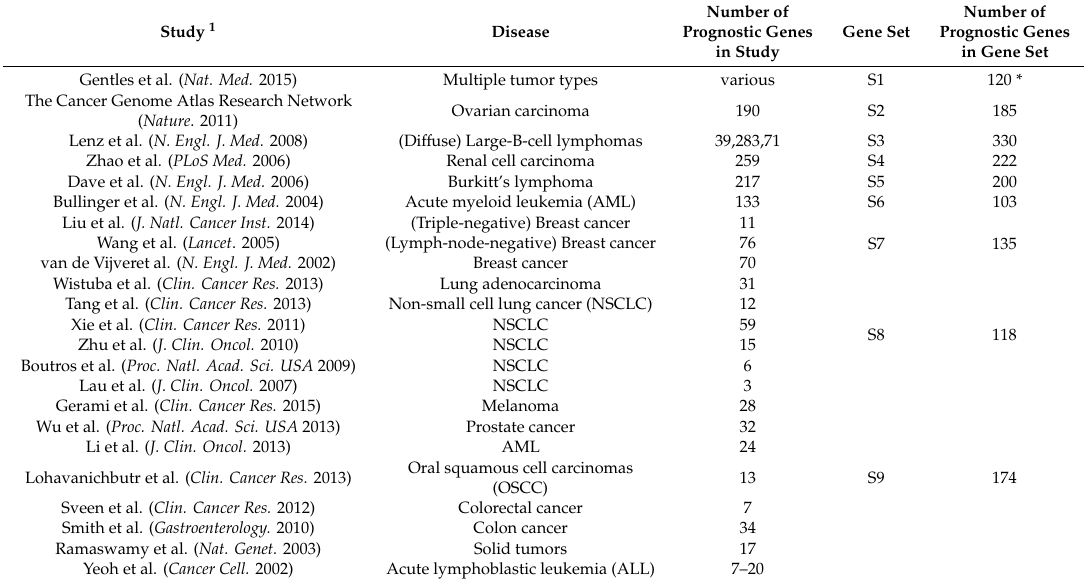
Table 1. List of literature sources, cancer types and sizes of prognostic gene sets in this